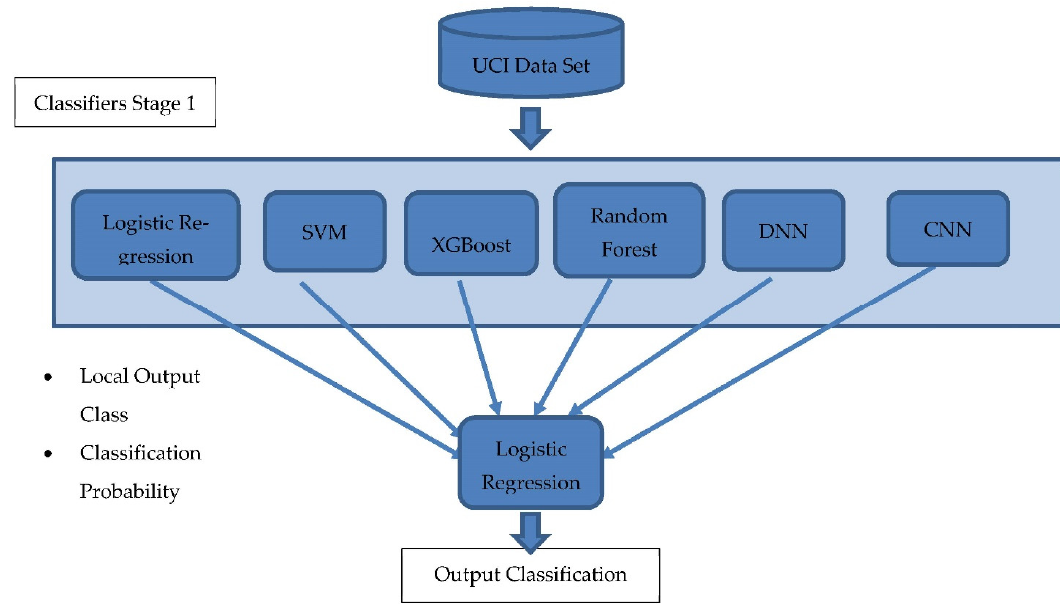
Figure 3. The proposed classification framework.